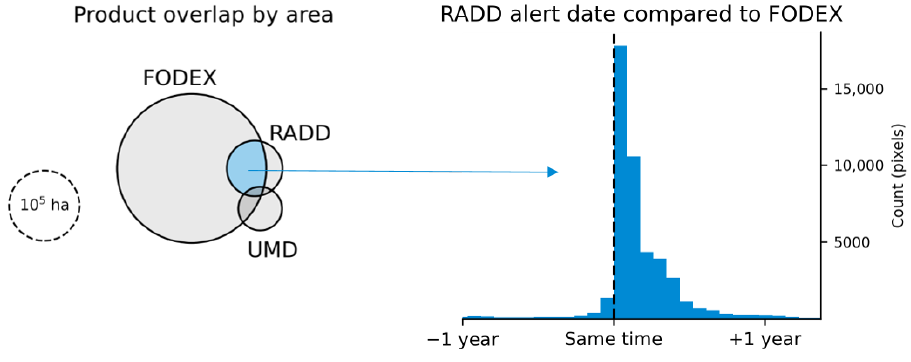
Figure 11. Comparison of forest degradation products for Gabon in 2020. ( left ) area of 1-ha cells where more than 10% was affected by canopy cover loss in our product (FODEX), forest disturbance in RADD Sentinel-1 alerts, forest loss in Landsat based UMD data, and their respective overlaps. ( right ) For areas where FODEX and RADD detected losses, the difference in estimated date of the